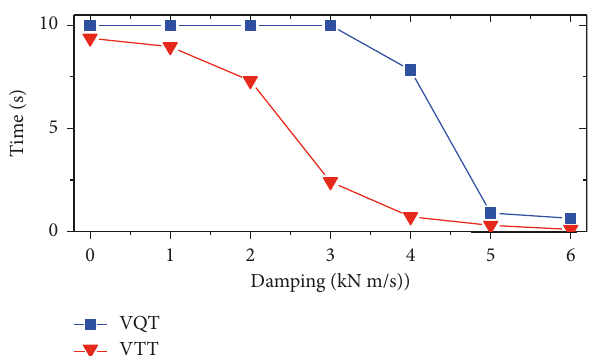
Figure 18: Vibration quit time and vibration total time of rod 2 with different damping coefficients ( c � 2.5, F